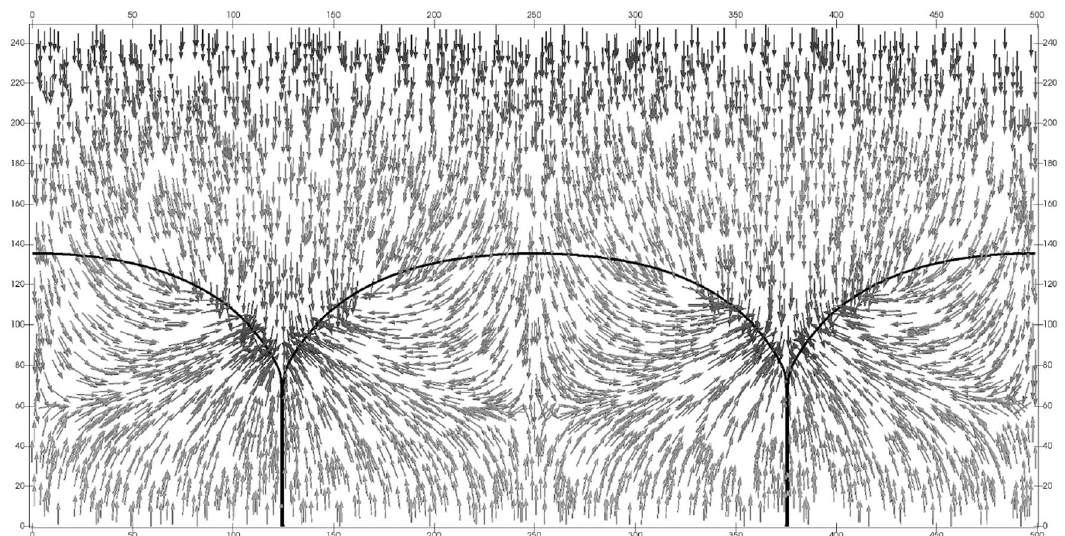
Fig. 8 Vector heat- fl ow map for the steady-state periodic GBG microstructure in Figs. 4 and 7. The s / ℓ interfaces and their grain boundaries are shown as heavy black borders. Heat fl ow introduced through the hotter liquid has trajectories that remain downward above the stationary s / ℓ interface. Heat fl ow locally de fl ects toward the cooler "blue valleys", contoured on the thermal map shown in Fig. 7. Downward fl ow vectors, upon entering the solid, rapidly change their directions. Cooling rates become largest close to the triple junctions, and fl ux vectors terminate their pathways where they enter the interface. The fl ow map shows general "convergence'' of heat vectors associated with the applied temperature fi eld toward capillary-cooled s / ℓ isolines, especially near the microstructure ’ s triple